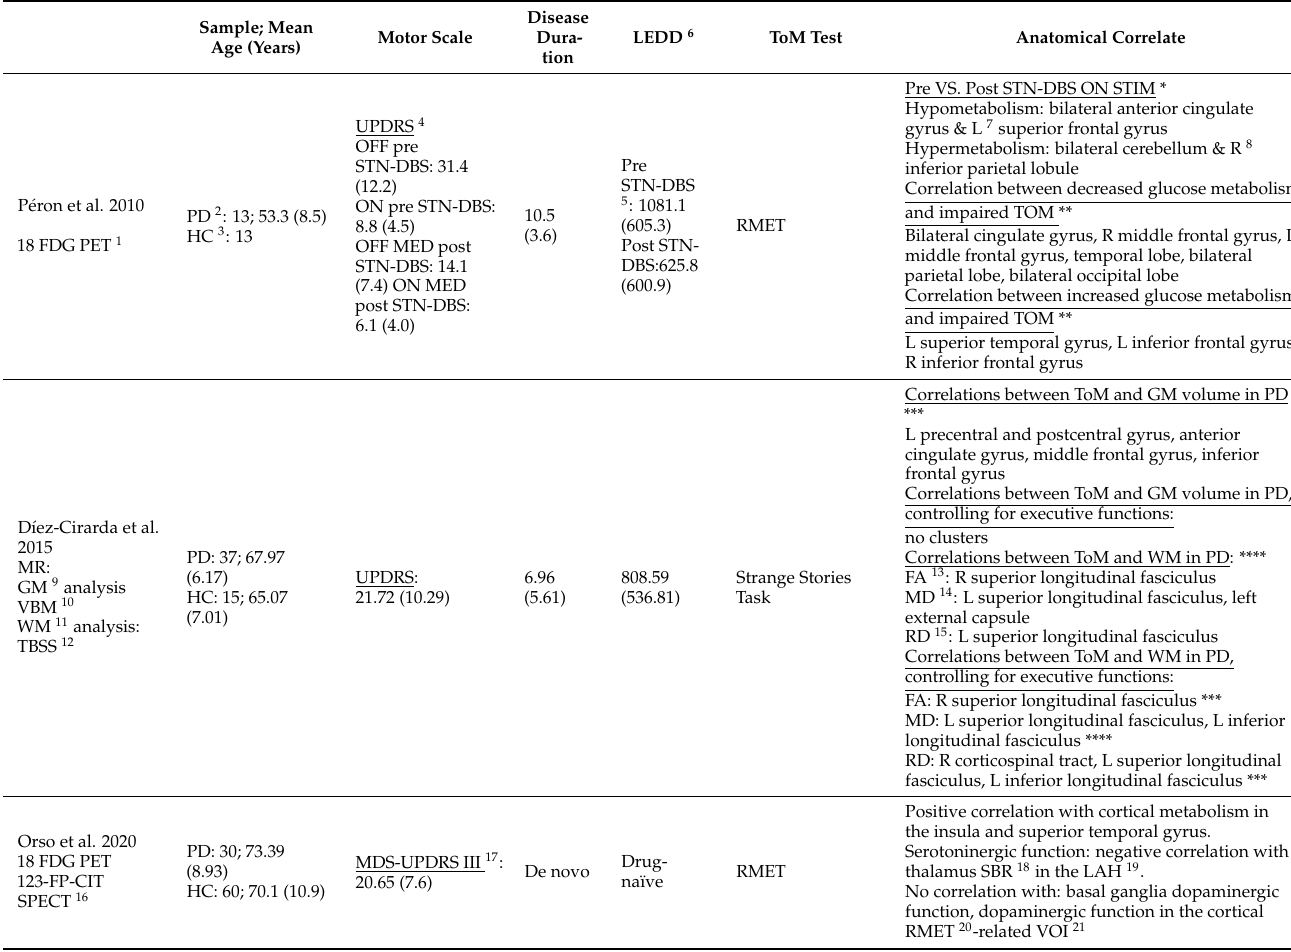
Table 1. Neuroimaging studies in Parkinson’s disease and ToM.